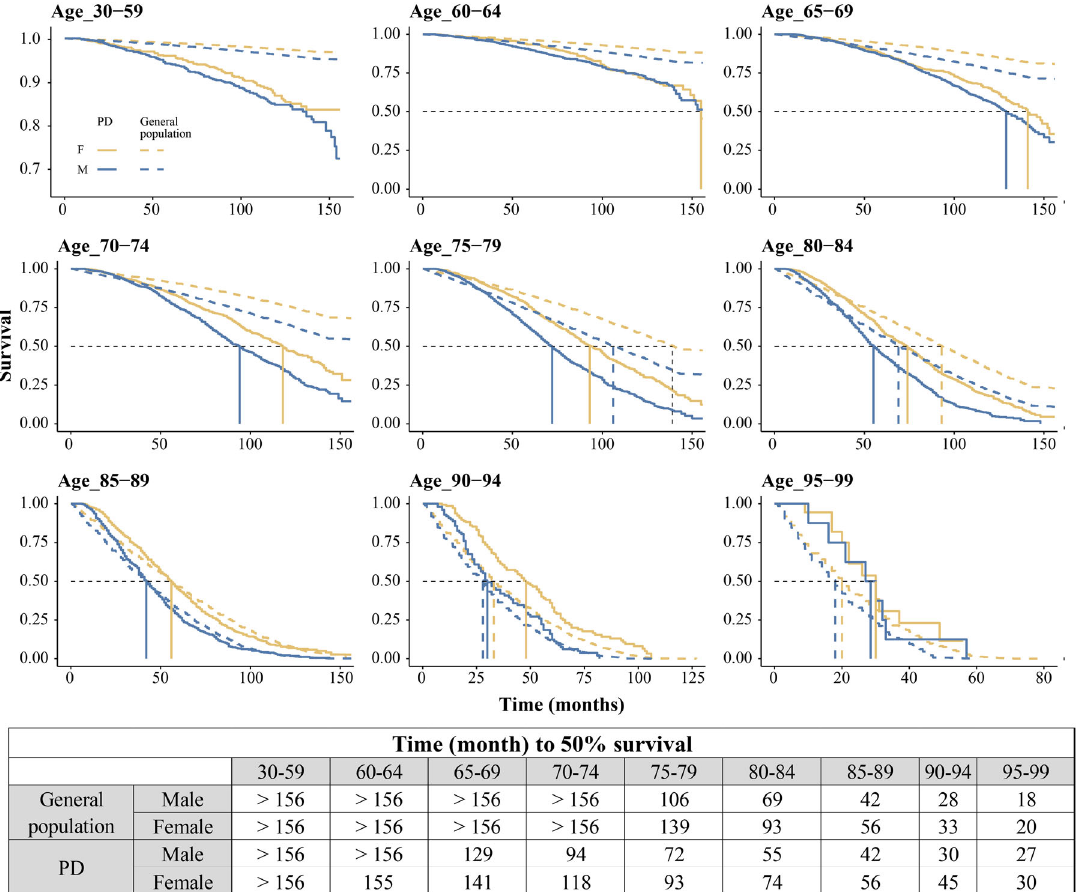
Fig. 3 Survival analysis showing sex differences. Kaplan – Meier survival curves for males (blue) and females (yellow) with PD (solid line) and general population (dashed line) in Norway 2005 – 2017. In both sexes, the differences in survival between individuals with PD and general population is only apparent among individuals with diagnosis age <85. Black dashed line represents 50%